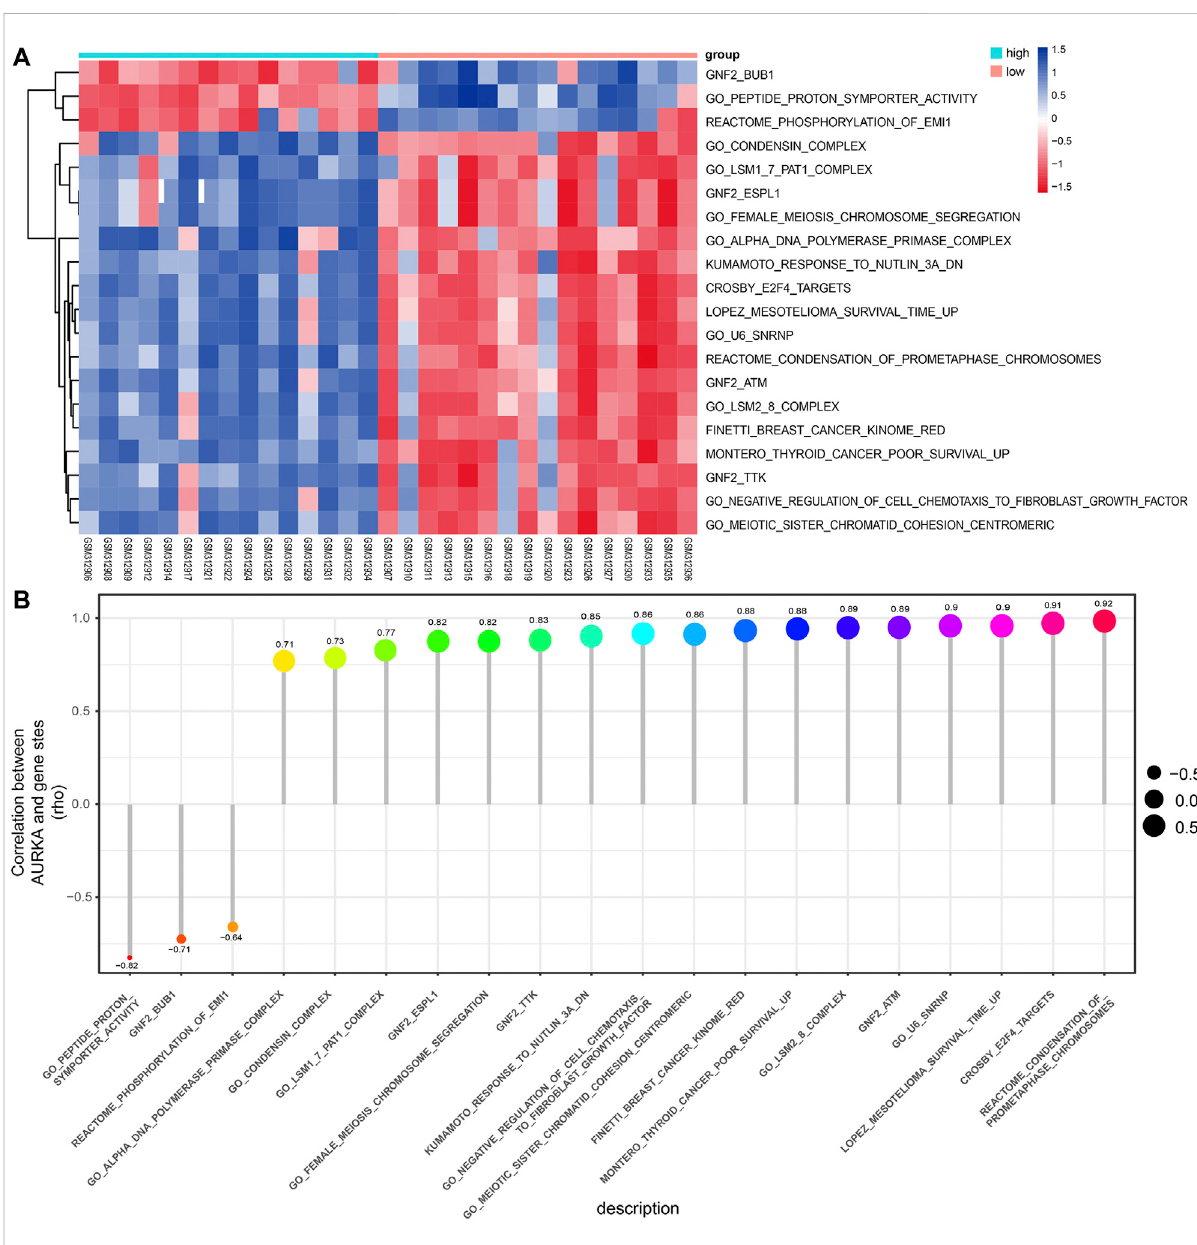
FIGURE 7 GSVA analysis of the Hub genes. (A) . Heatmap showing differential pathway heatmap quanti fi ed by GSVA. Red represents high enrichment, and blue indicates the opposite; (B) . Correlation of AURKA gene with differential pathways. Larger points are more relevant. GSVA, gene set variation analysis; AURKA , Aurora kinase (A)